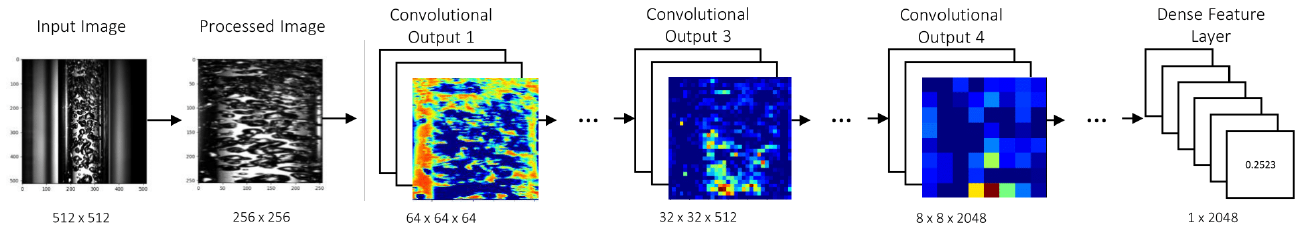
Figure 4. Image feature reduction: FrameNet passes an input image through a series of convolutional layers to identify the reduced image features in the form of a set of single values, useful for frame classification.